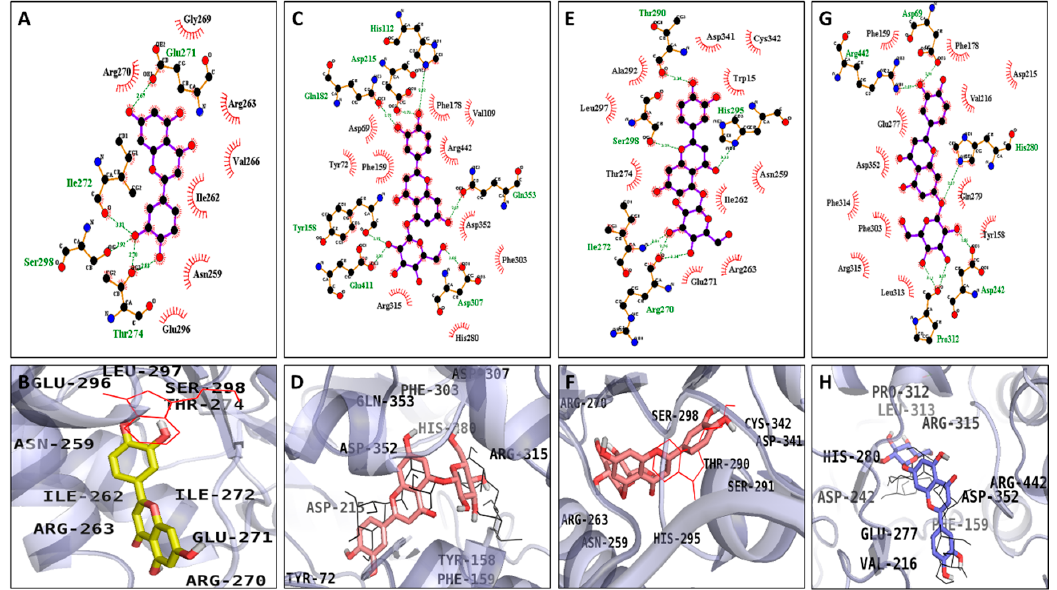
Figure 6. 2D ( A , C , E , and G ) and 3D ( B , D , F , and H ) diagrams of α -glucosidase inhibition by luteolin 2D ( A , C , E , G ) and 3D ( B , D , F , H ) diagrams of α -glucosidase inhibition by luteolin (allosteric inhibition, A and B ), luteolin 5- O - β - D -glucopyranoside (catalytic inhibition, C and D ), (allosteric inhibition, A , B ), luteolin 5- O - β - D -glucopyranoside (catalytic inhibition, C , D ), luteolin luteolin 5- O - β - D -glucopyranoside (allosteric inhibition, E and F ), and luteolin 7- O - β - D 5- O - β - D -glucopyranoside (allosteric inhibition, E , F ), and luteolin 7- O - β - D glucopyranoside (catalytic glucopyranoside (catalytic inhibition, G and H ). Luteolin, luteolin 5- O - β - D glucopyranoside, luteolin inhibition, G , H ). Luteolin, luteolin 5- O - β - D glucopyranoside, luteolin 7- O - β - D -glucopyranoside, 7- O - β - D -glucopyranoside, acarbose, and BIP are represented by yellow, bold red, blue, black, and red acarbose, and BIP are represented by yellow, bold red, blue, black, and red colored structures, colored structures, respectively.